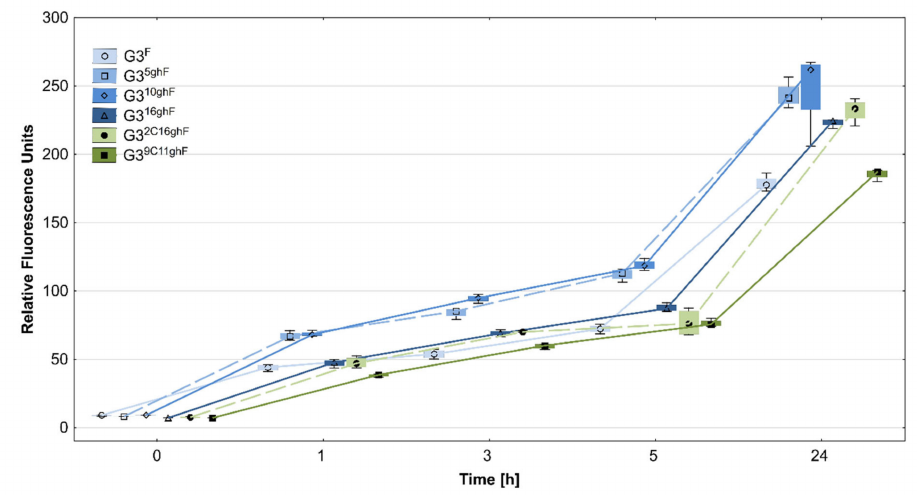
Figure 11. The time-dependent accumulation of 1 µ M G3 F , G3 5ghF , G3 10ghF , G3 16ghF , G3 2C16ghF , and G3 9C11ghF conjugates after 1, 3, 5, or 24 h incubation: Results are presented as a median of relative fluorescence units. Boxes indicate upper (75%) and lower (25%) quartile ranges. Whiskers are minimum and maximum values.